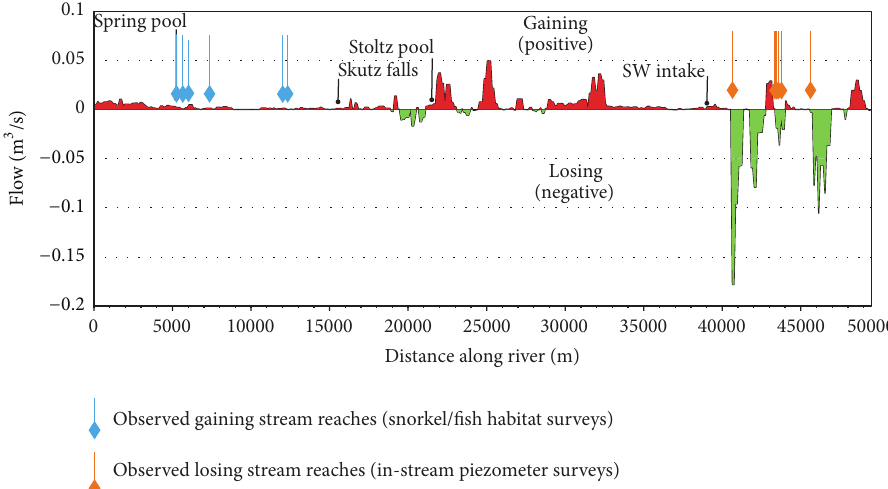
Figure 16: Comparison between simulated exchange conditions and observed springs (GW inflow) and in-stream losing piezometric survey locations. Table 6: Comparison of mean monthly water balance results for the baseline and 2080s (mm/month and percent change). Parameter Precipitation ET